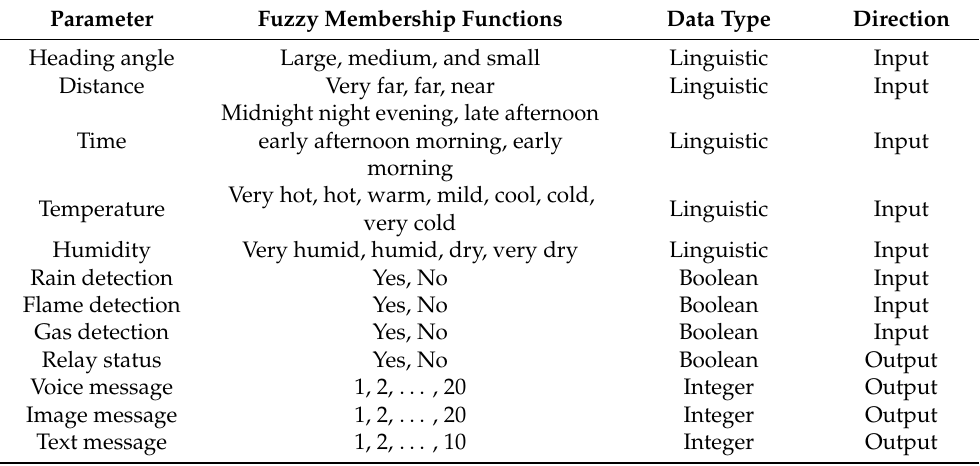
Table 1. Explanation of outputs and inputs of fuzzy decision-making unit. The fuzzy membership functions of each variable can be discrete or have a Gaussian distribution according to their data